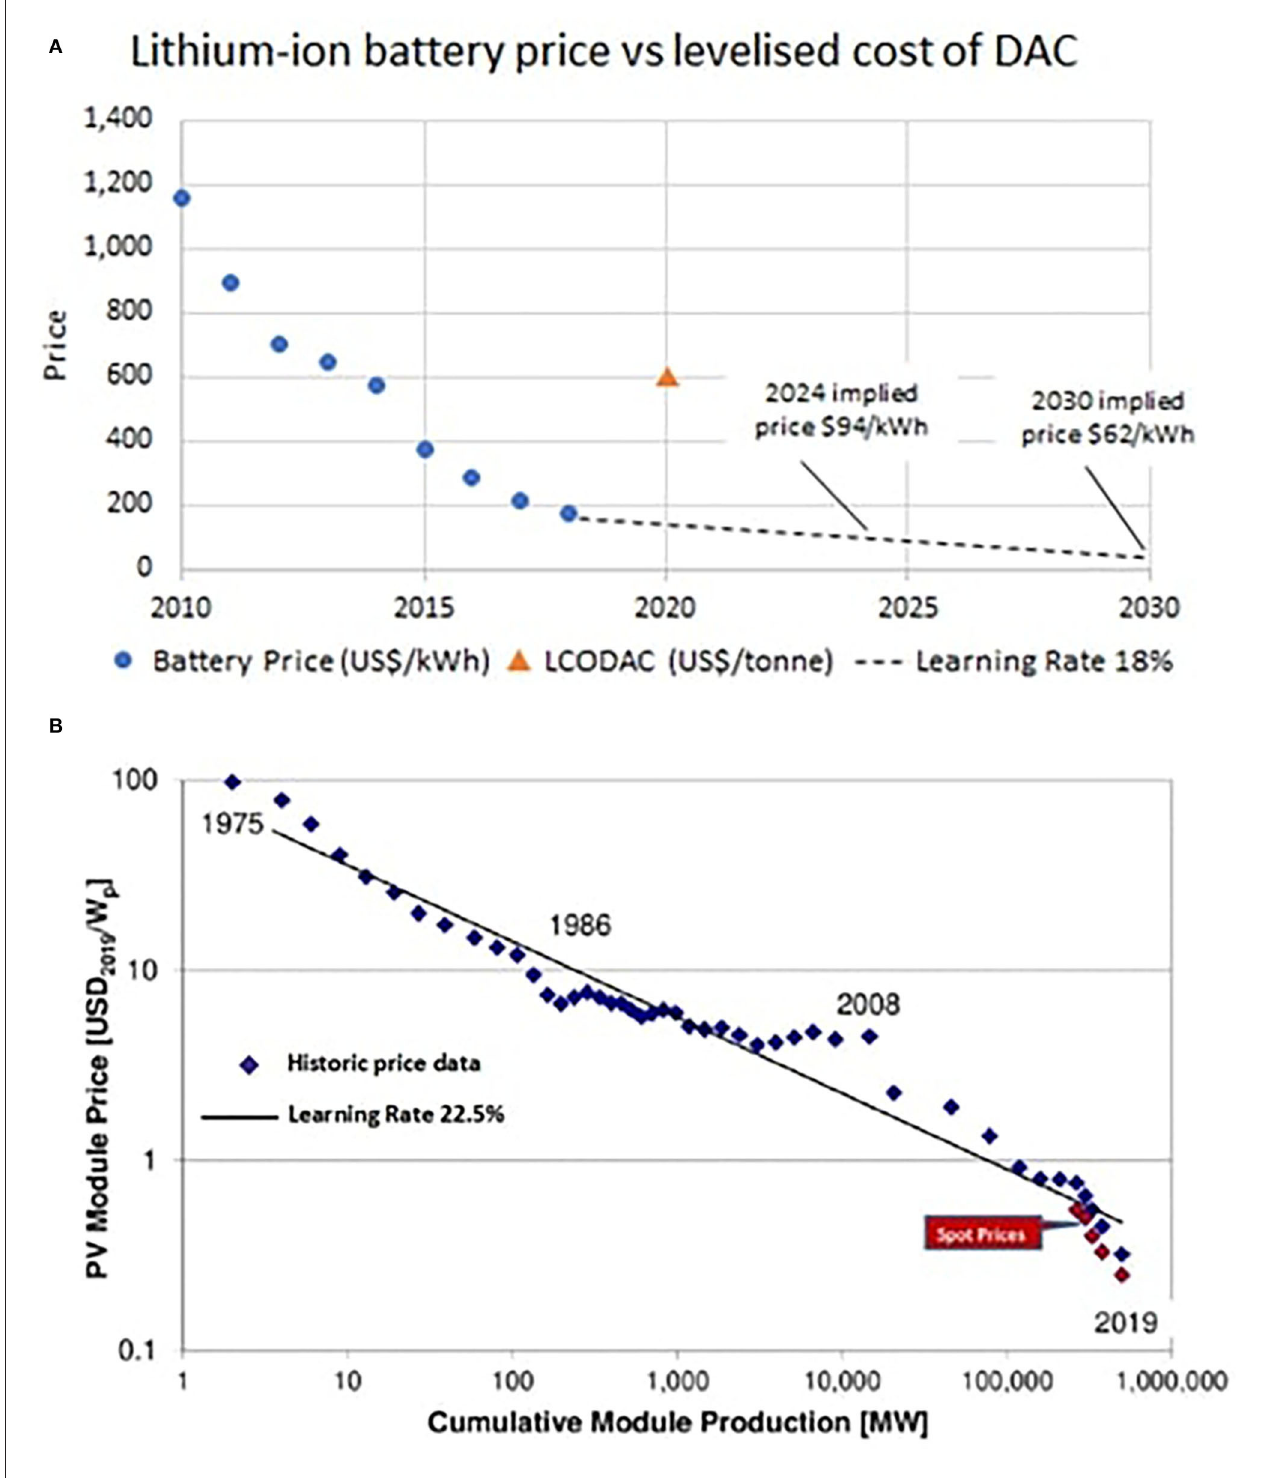
FIGURE 1 | (A) Lithium-ion battery cost-curve and forecast alongside levelised cost of DAC. Graph by Carbon Infinity, based on Bloomberg New Energy Finance (Goldie-Scot, 2019) Graph and BloombergNEF Data. (B) Solar PV module cost curve illustrating Swanson’s law and the corresponding learning curve for solar PV. Graph by Carbon Infinity, based on European Commission’s PV Status Report (Jäger-Waldau, 2019) Graph and BloombergNEF and PV News Data.